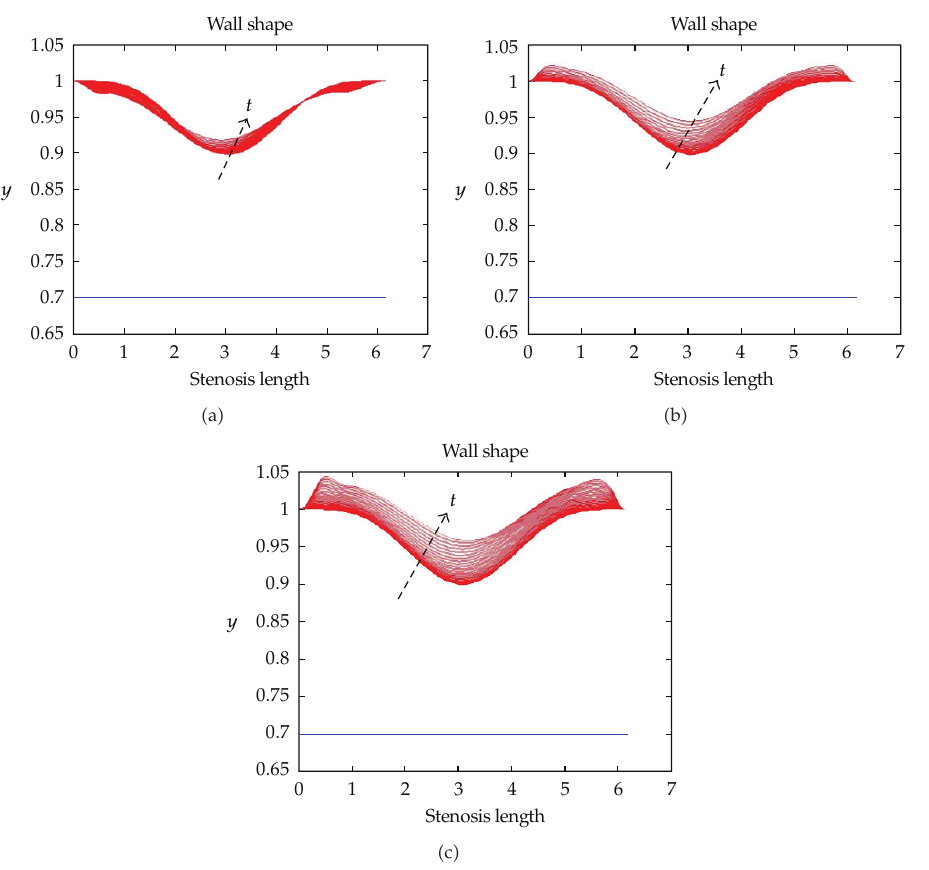
Figure 8: Wall shape for inlet transmural pressure, P to (cid:7) 180Pa (cid:3) a (cid:4) , 200Pa (cid:3) b (cid:4) , 220Pa (cid:3) c (cid:4)